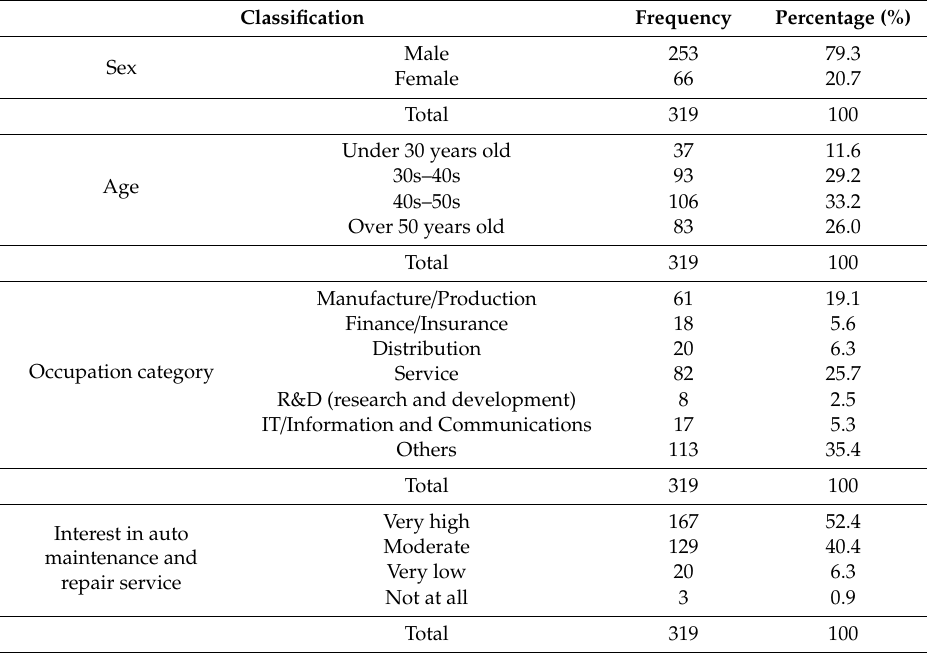
Table 2. Demographics of survey